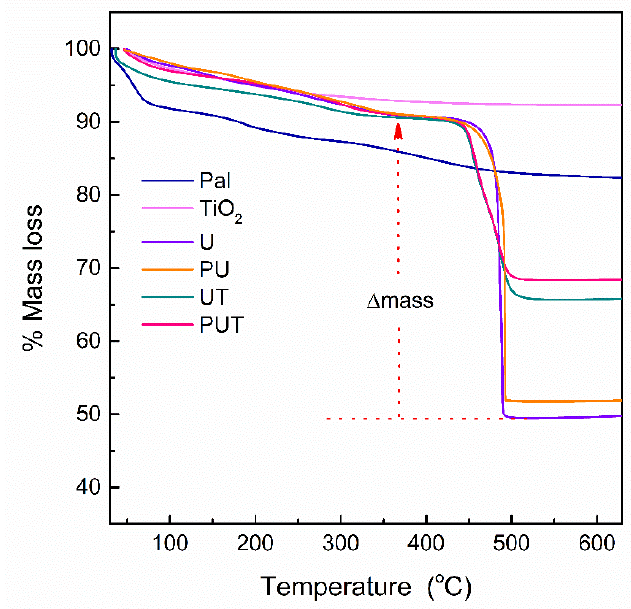
Figure 3. TGA profiles of the pure Pal and TiO 2 samples and the prepared U, PU, and PUT materials. Diffuse reflectance UV/Vis spectroscopy was applied to study the electronic properties related with light absorption. Figure 4a presents the UV/Vis absorption spectra of the materials. The corresponding Tauc plots [38,39,53] used to estimate the bandgap energies absorption onset was observed for the PU sample. This corresponded to E g values of